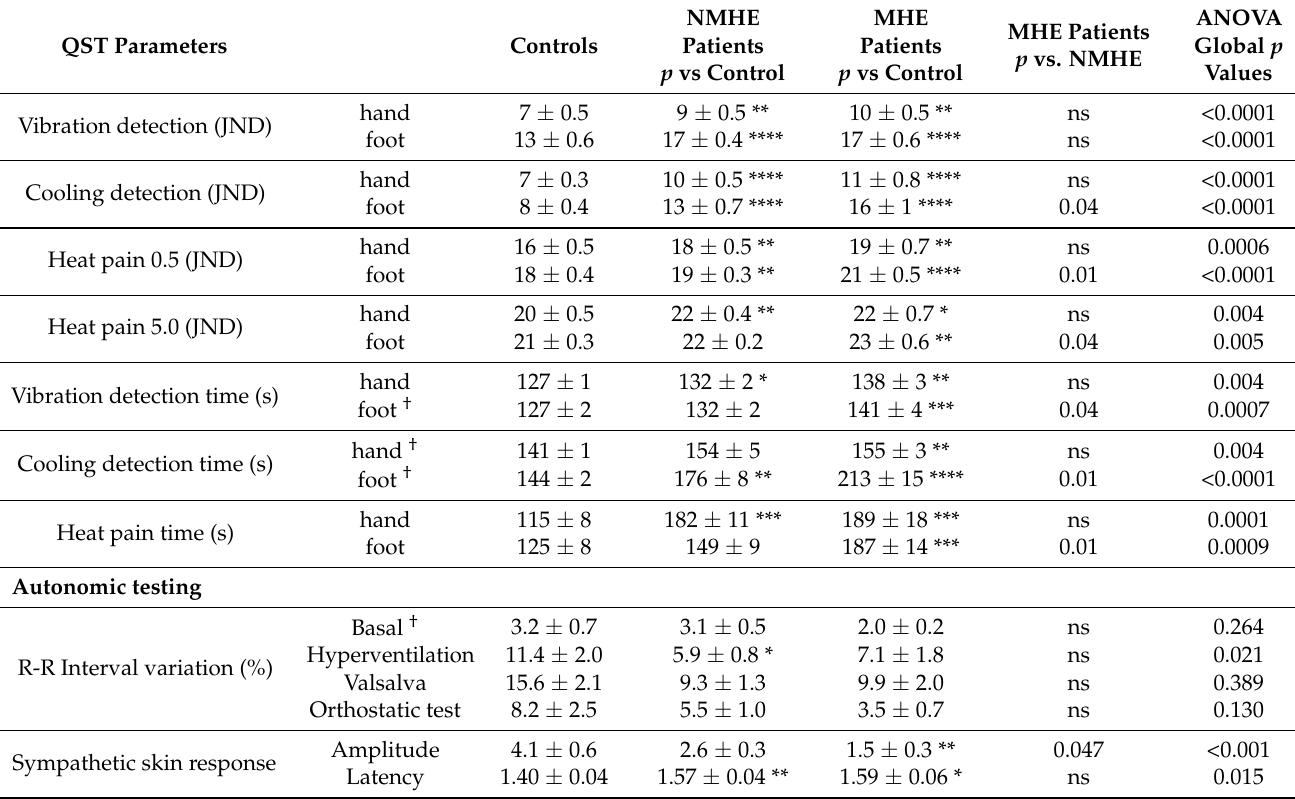
Table 3. Comparison of QST parameters and autonomic testing in controls and cirrhotic